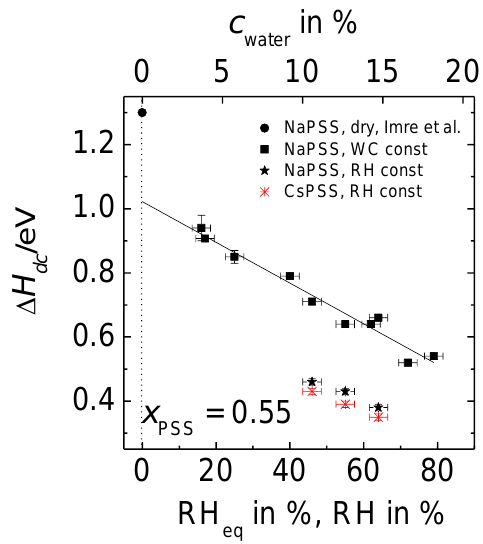
Figure 7. Activation enthalpies of x MPSS∙(1 − x ) PDADMAC with x PSS = 0.55 obtained at constant water content (squares) and at constant relative humidity (stars) in dependence on RH eq or RH, respectively. The water content of the PEC in % (upper x -axis) corresponds to RH eq of the constant water content (cWC) series (lower- x -axis). Data at constant RH have been determined for PEC with NaPSS (filled stars) and CsPSS (stars), respectively. The circle refers to completely dried PEC and has been taken from Reference [26].